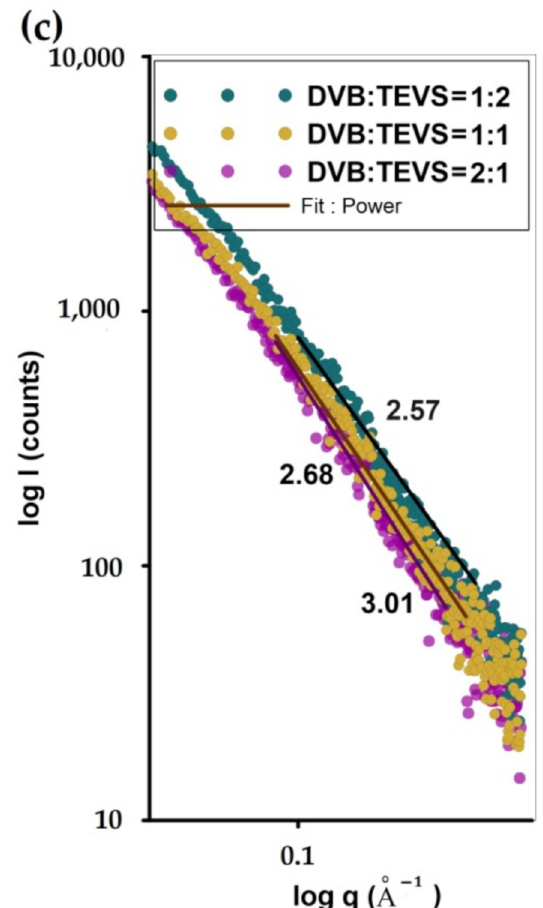
Figure 3. Experimental SAXS profiles corresponding to hybrid microspheres with various amounts of organic and inorganic components ( a ) Porod plots, and Porod constants determined from experimental patterns ( b ). The black arrows show the range of scattering vector suitable for the Porod linear range. The log-log plots of SAXS intensity in the power-law range ( c